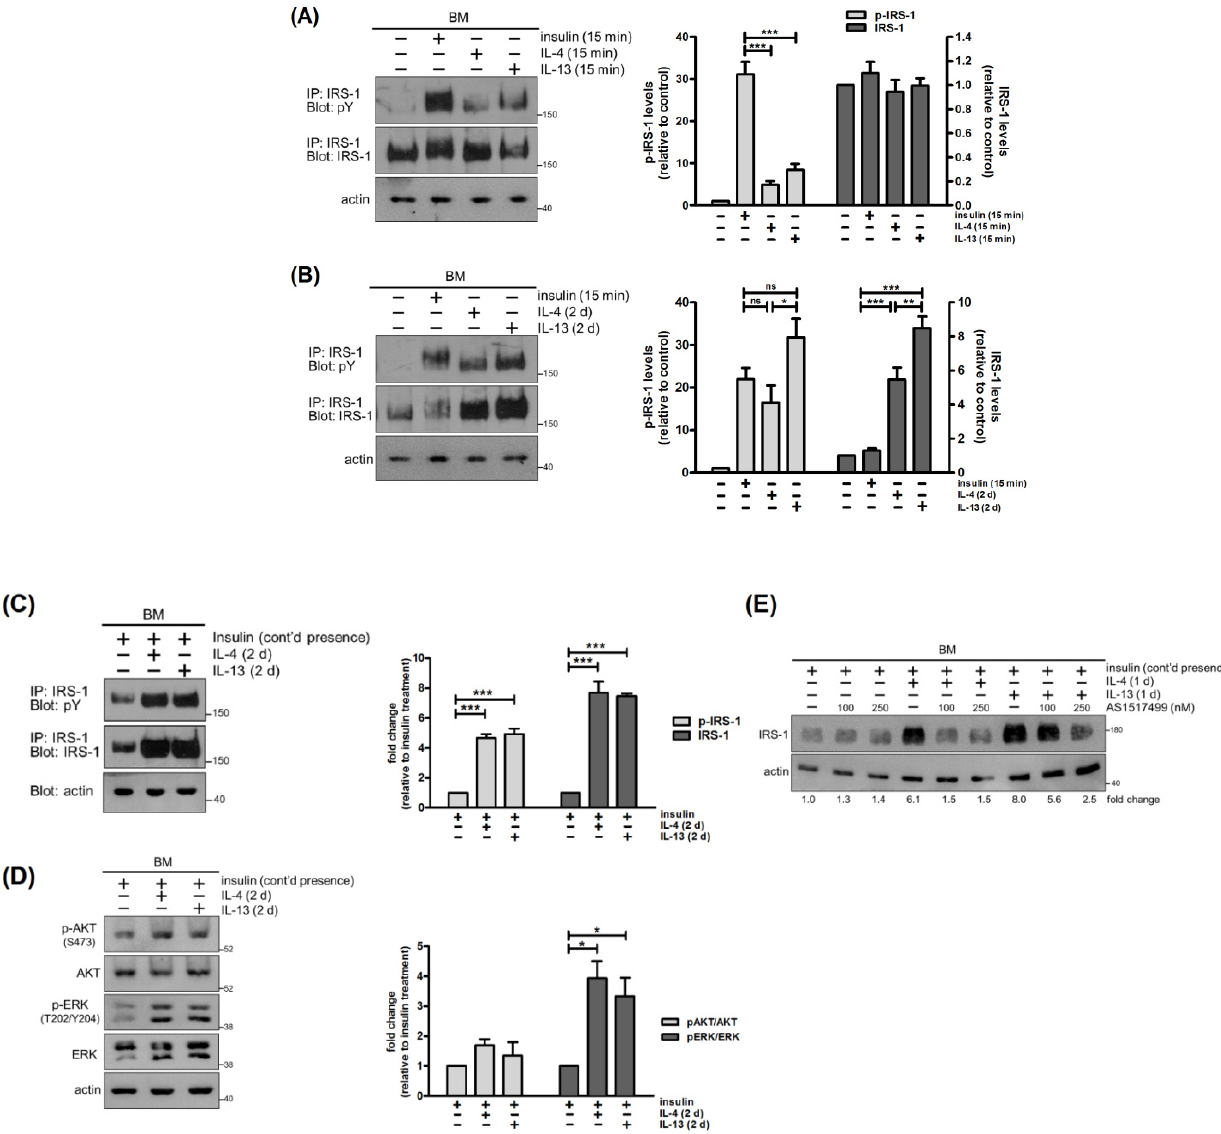
Figure 4. IL-4 and IL-13 stimulate tyrosine phosphorylation and expression of IRS-1. Mammary cells were cultured on a basement membrane (BM)-like matrix, Matrigel, either in the absence of insulin ( A , B ) or in the continued presence of insulin ( C – E ). ( A ) Cells were untreated or stimulated with insulin (100 nM), IL-4 or IL-13 for 15 min ( n = 5). ( B ) Cells were untreated for 2 d, untreated for 2 d and then stimulated with insulin for 15 min, or treated with IL-4 or IL-13 for 2 d ( n = 5). ( C ) Cells were stimulated with IL-4 or IL-13 for 2 d in the continued presence of insulin ( n = 3). Total cell lysates were immuoprecipitated (IP) with antibody to IRS-1 followed by immunoblotting with antibody to phosphotyrosine (pY). Blots were stripped and reprobed with antibody to IRS-1. Total cell lysates were also analyzed by immunoblotting with antibody to actin. Actin was used as a loading control. ( D ) Cells were stimulated with IL-4 or IL-13 for 2 d in the continued presence of insulin. Total cell lysates were analyzed by immunoblotting with antibodies to phospho-AKT (p-AKT), AKT, phospho-ERK (p-ERK), ERK and actin. ( n = 3) ( E ) Cells were pretreated with STAT6 inhibitor AS1517499 (100 nM, 250 nM) for 1 h and stimulated with IL-4 or IL-13 for 1 d in the continued presence of insulin. Total cell lysates were analyzed by immunoblotting with antibodies to IRS-1 and actin. Data were quantified, normalized to loading control and expressed as fold change relative to control ( A , B , E ) or insulin treatment ( C , D ). * p < 0.05, ** p < 0.01, *** p < 0.005; and ns, not